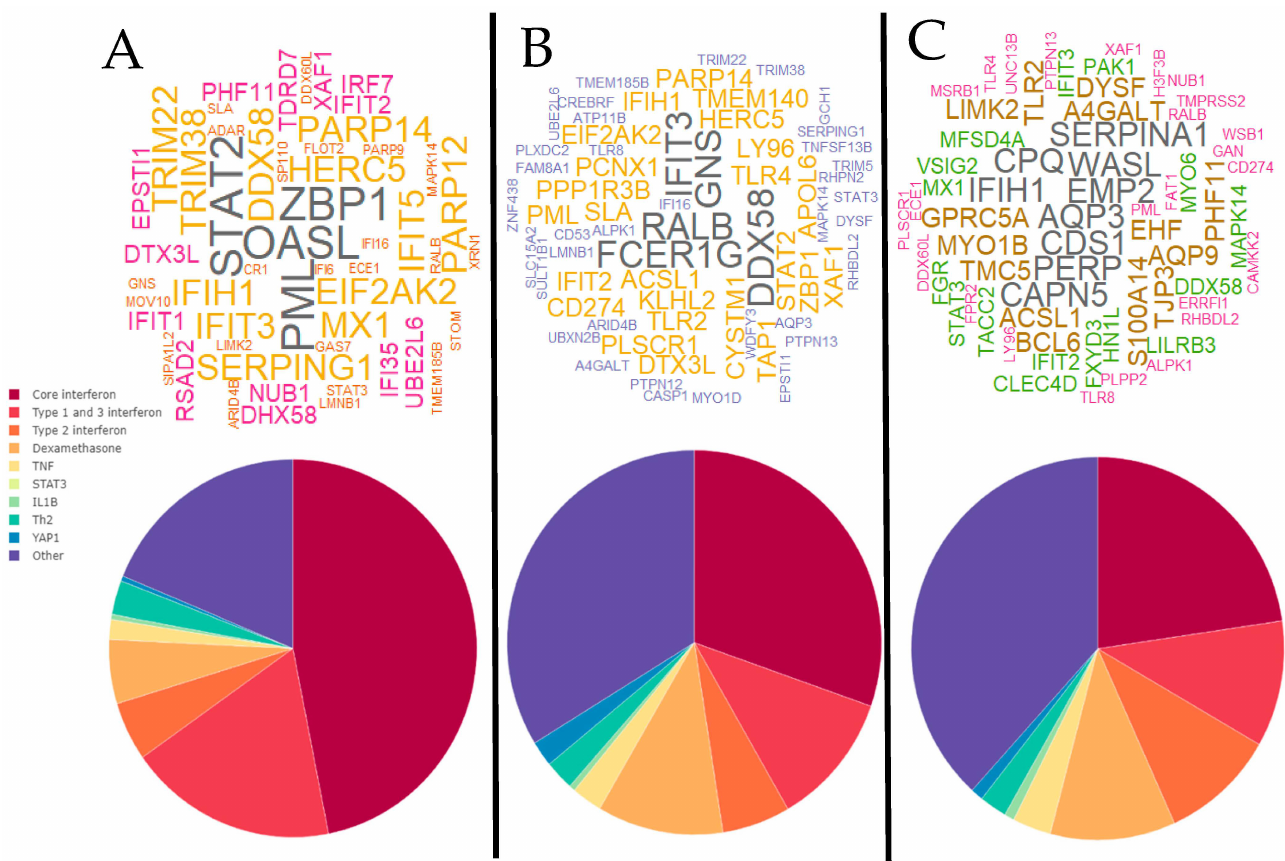
Figure 11. Word cloud plots of the top 20 hub genes for each individual at the late (Day 4–6) visit ( top ) and averaged network pathway proportions ( bottom ) for clusters A, B, and C. Word color and size indicates